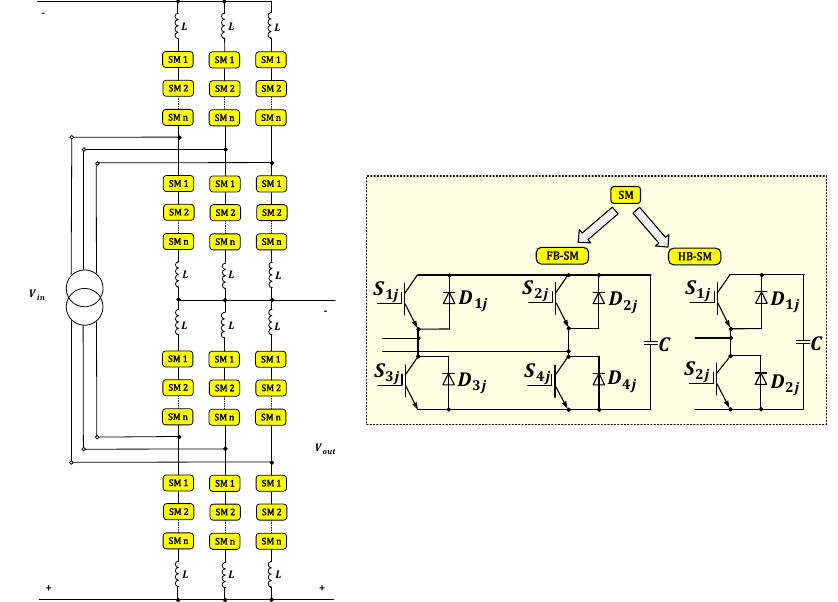
Figure 8. MVDC Auto-Transformer (MVDC-AT) converter circuit diagram.